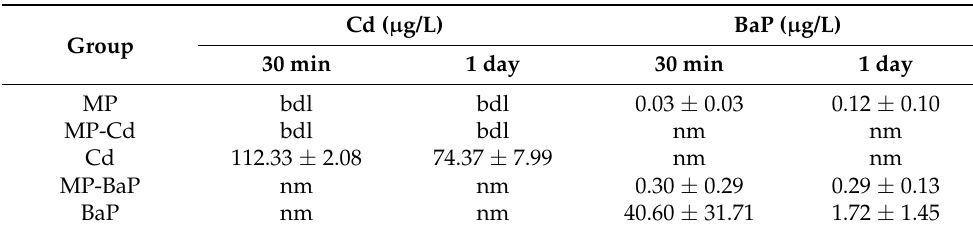
Table 4. Results of the chemical analyses of Cd and BaP concentrations in water samples of the second experiment. Samples were collected 30 min and 1 day after each dosing. Data are expressed as mean ± standard